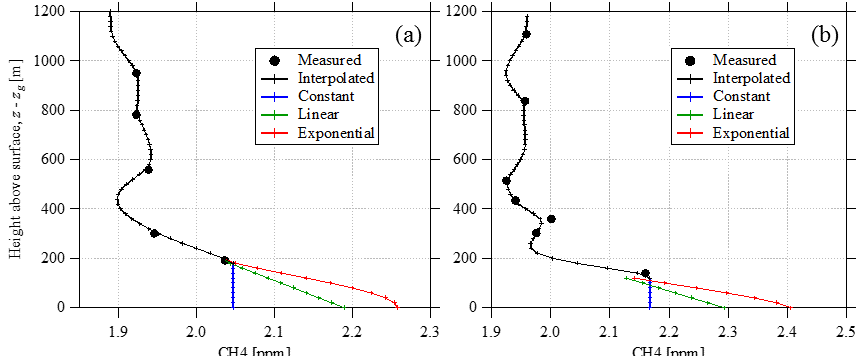
Figure 6. CH 4 mixing ratios with height above ground for the 20 August flight (a) at s = 12 . 4km and for the 2 September flight (b) at s = 50 . 4km. Measured values within ± 40m ( (cid:49)s) are shown as dots; kriging-interpolated values ( z > z L (s) , black lines) are compared to extrapolated values ( z < z L (s)) for constant (blue), linear-fit (green), and exponential-fit (red) values. Background values on each day were approximately